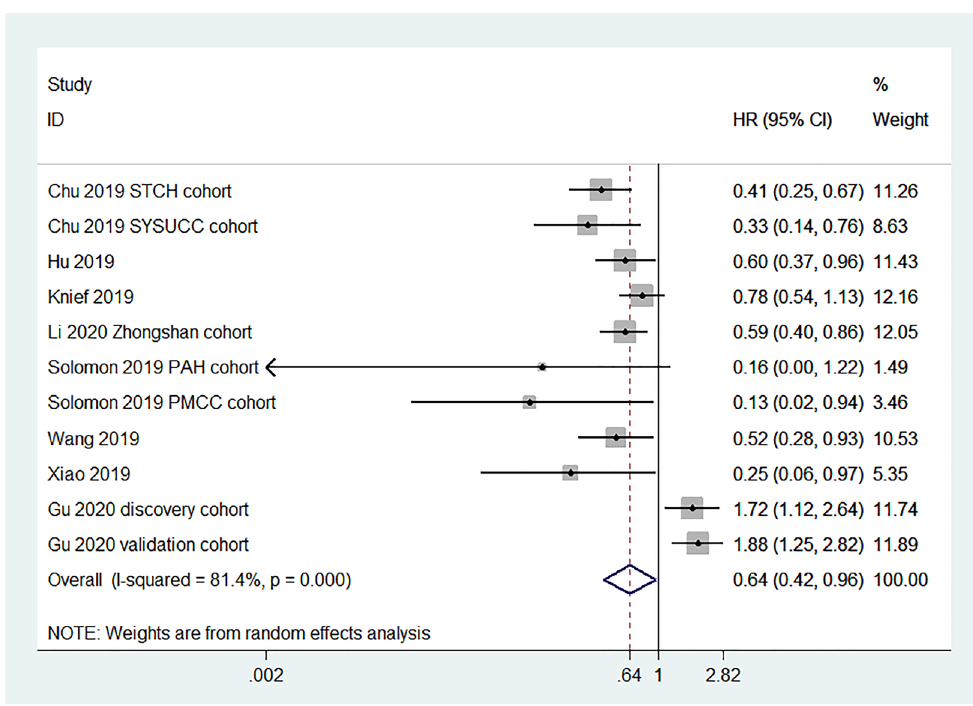
Fig. 3. Forest plot of all the included studies.